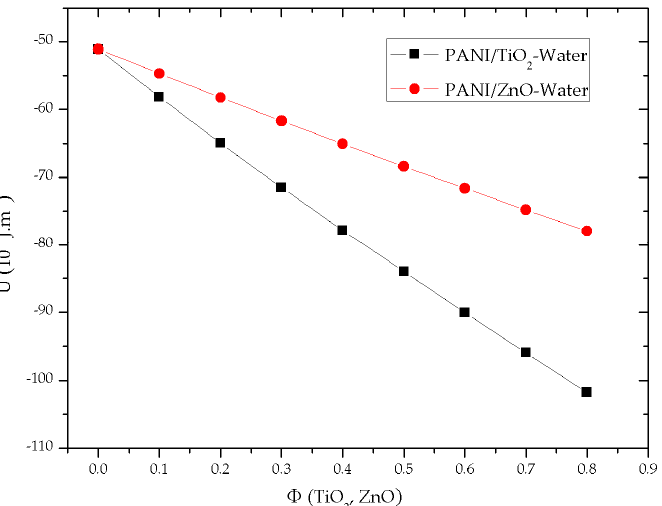
Figure 4. VdW energy U between PANI/NPs ‐ Water across air as a function of the volume fraction Φ of TiO 2 and ZnO NPs.